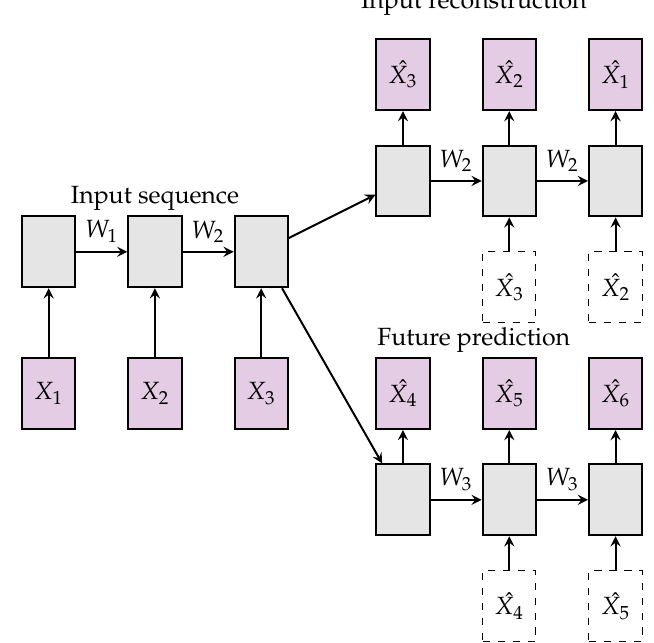
Figure 5. Composite LSTM module [7]. The LSTM model weights W represent fully connected